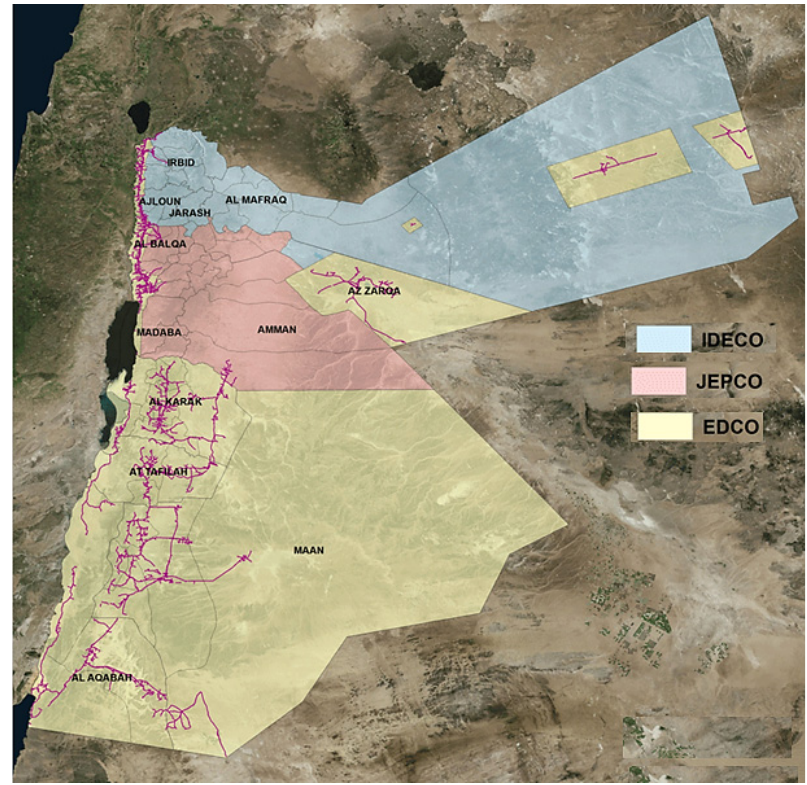
Figure 2. The JEPCO, EDCO and IDECO electricity distribution regions in Jordan.